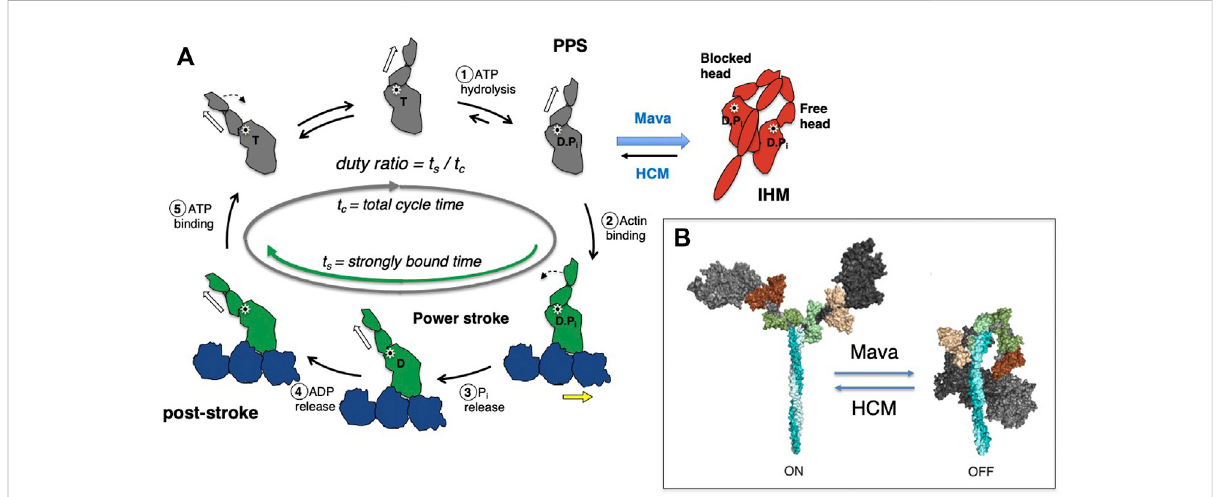
FIGURE 2 (A) Chemomechanicalcycleofmyosininteractingwithactin.Onlyonehead(S1motor)isbeingdepictedinthecycleforclarity. 1 )S1hydrolyzes ATP to ADP and phosphate (Pi), which remain bound in theactive site, stabilizing the pre-powerstroke state (PPS, white arrow istilted to theright). 2 ) The PPS S1-ADP-Pi binds strongly (grey to green) to actin (blue). 3 ) Pi is released while S1 is bound to actin and the lever arm swings to the left (black dashed arrow) about a fulcrum point (black star), moving the actin fi lament to the right (yellow arrow) with respect to the myosin thick fi lament (power stroke). 4 ) ADP release allows a further small stroke to the poststroke position (white arrow to the left) and frees the active site for binding of ATP. 5 ) ATP binds and weakens the interaction of S1 and actin, releasing S1 from the actin fi lament. S1 undergoes a recovery stroke to the PPS state (dotted arrow; white arrow moves from the left to the right). S1 in the pre-powerstroke con fi guration can be pulled into the folded IHM state (red). Mavacamten (Mava) affects the equilibrium of these heads as shown, and stabilizes the IHM form, whereas HCM mutations destabilize the IHM in many cases and shift more myosin into the cycle. In the cycle, weakly bound and detached S1 motors are shown in gray,and strongly bound motors are shown in green. (B) Structural homology models of cardiac myosin showing the effect of HCM mutations shifting the equilibrium toward the open state (ON), and mavacamten treatment shifting the equilibrium toward the folded state